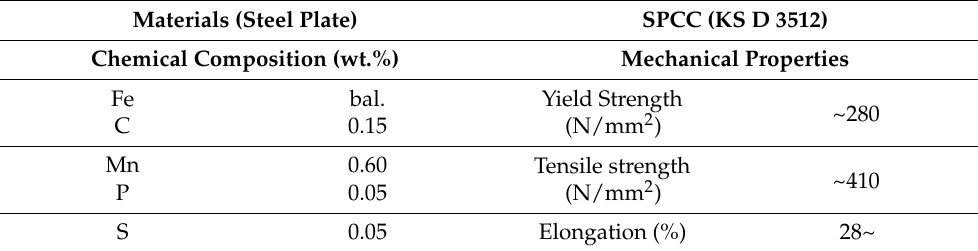
Figure 1. Experimental schematic diagram of electrodeposition process in artificial seawater and natural seawater: ( a ) schematic diagram of a specimen; ( b ) schematic diagram of electrodeposition experiment in various synthesized solutions. Table 1. Chemical composition and mechanical properties of specimen.